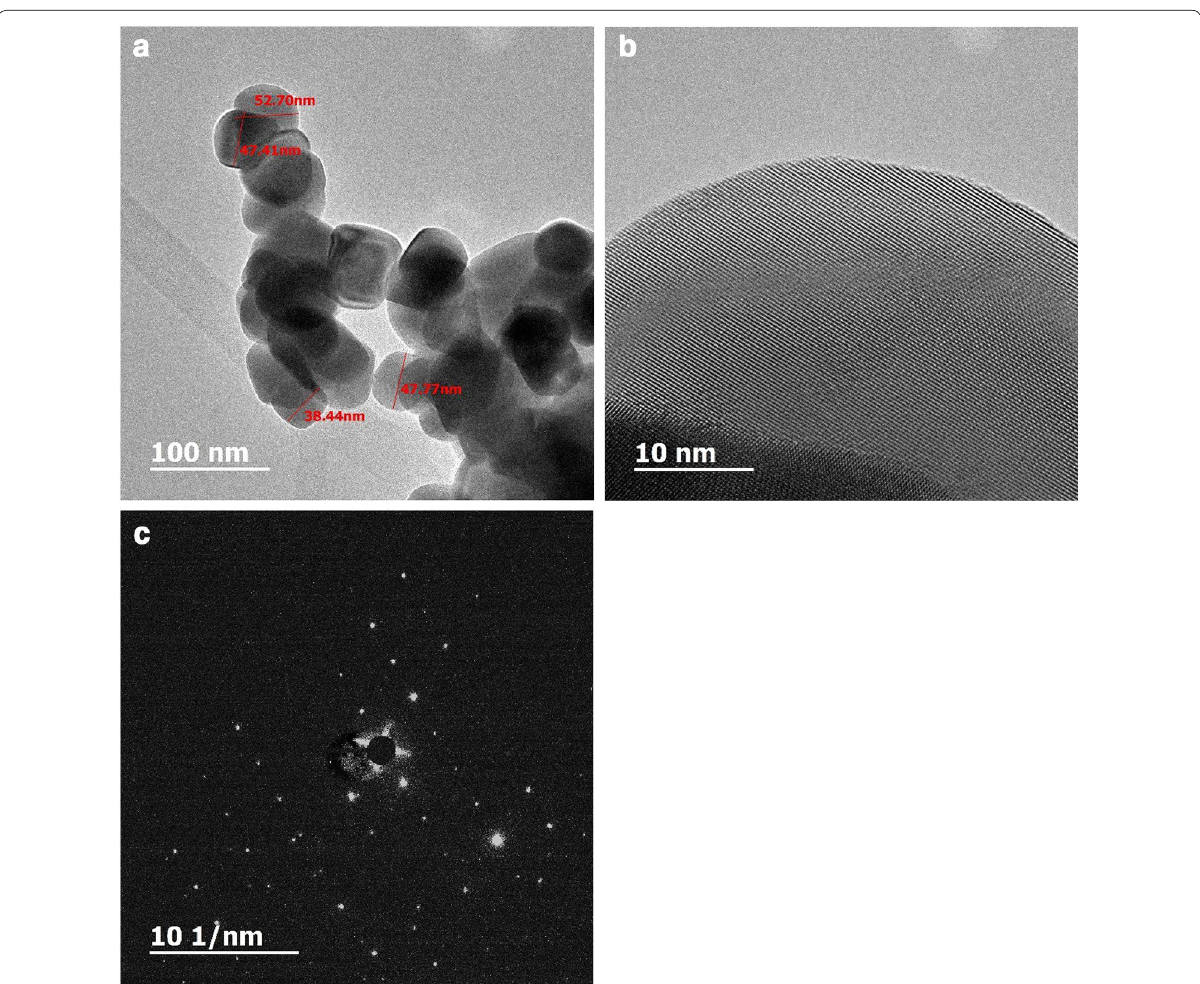
Fig. 2 a HRTEM observation, b its magnification and c SAED pattern of ITO‑NPs synthesized with reverse reduction in situ method and heat‑treat‑ ment at 980 °C